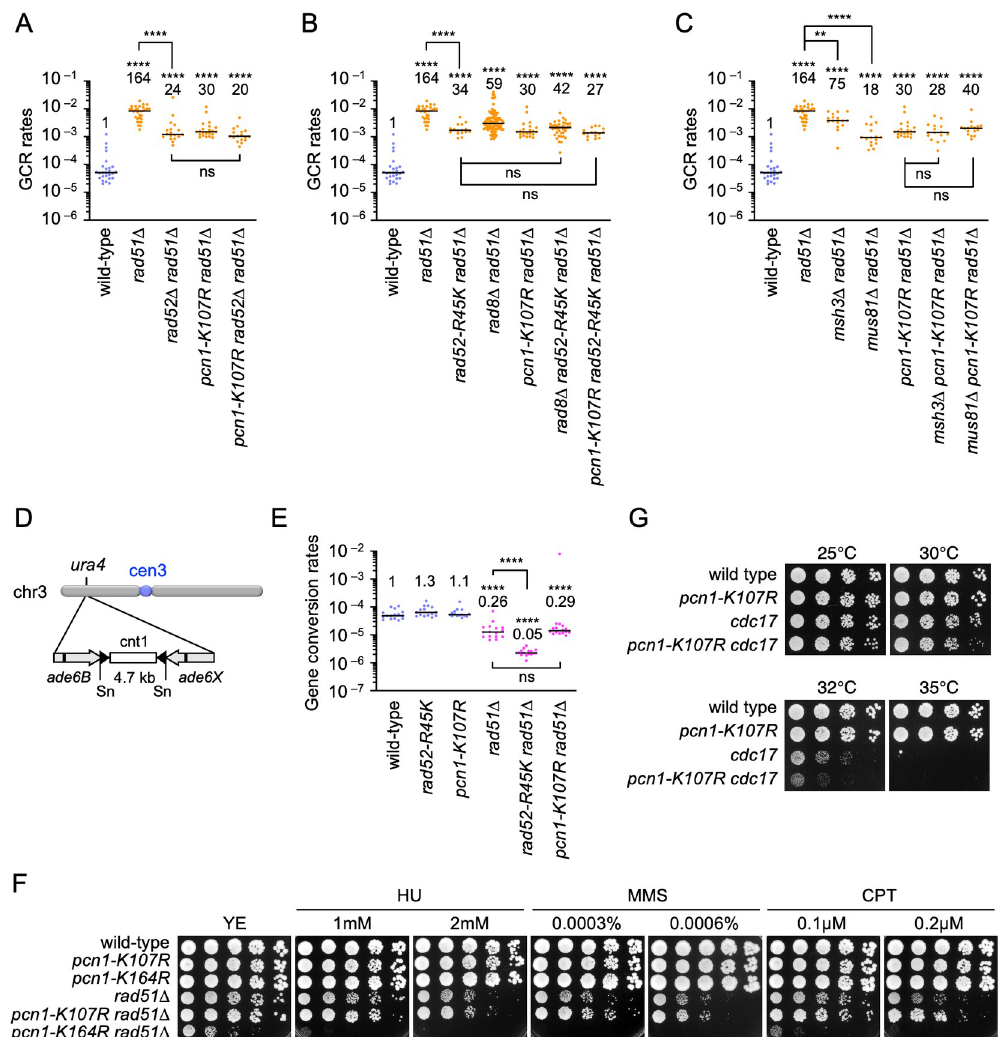
Fig 4. PCNA K107 is involved in the Rad52-dependent GCR pathway. (A) GCR rates of the wild-type, rad51 Δ , rad52 Δ rad51 Δ , pcn1-K107R rad51 Δ , and pcn1-K107R rad52 Δ rad51 Δ strains (TNF5369, 5411, 6692, 6761, and 6922, respectively). (B) GCR rates of the wild-type, rad51 Δ , rad52-R45K rad51 Δ , rad8 Δ rad51 Δ , pcn1-K107R rad51 Δ , rad8 Δ rad52-R45K rad51 Δ , and pcn1-K107R rad52-R45K rad51 Δ strains (TNF5369, 5411, 6616, 5644, 6761, 6704, and 7006, respectively). (C) GCR rates of the wild-type, rad51 Δ , msh3 Δ rad51 Δ , mus81 Δ rad51 Δ , pcn1-K107R rad51 Δ , msh3 Δ pcn1-K107R rad51 Δ , and mus81 Δ pcn1-K107R rad51 Δ strains (TNF5369, 5411, 7081, 5974, 6761, 6990, and 7203, respectively). (D) A schematic diagram illustrates the ade6B and ade6X inverted repeats integrated at the ura4 locus on the arm region of chr3. Sn, SnaBI. (E) Rates of gene conversion between ade6B and ade6X heteroalleles in the wild-type, rad52-R45K , pcn1-K107R , rad51 Δ , rad52-R45K rad51 Δ , and pcn1-K107R rad51 Δ strains (TNF3631, 5995, 7837, 3635, 6021, and 7918 respectively). The two-tailed Mann- Whitney test. Non-significant (ns) P > 0.05; �� P < 0.01; ���� P < 0.0001. (F) DNA damage sensitivity. Exponentially growing cells of the wild-type, pcn1-K107R , pcn1-K164R , rad51 Δ , pcn1-K107R rad51 Δ , and pcn1-K164R rad51 Δ strains (TNF35, 6968, 6948, 2610, 6988, and 6986, respectively) in YE media were five-fold serially diluted with sterilized water and spotted onto YE plates supplemented with HU, MMS, or CPT, at the indicated concentrations. (G) A serial dilution assay to examine temperature sensitive growth. Log-phase cultures of the wild-type, pcn1-K107R , cdc17-K42 , and pcn1-K107R cdc17-K42 strains (TNF35, 6968, 604, and 6973, respectively) prepared at 25˚C in YE media were five-fold serially diluted and spotted onto YE plates. The plates were incubated at the indicated temperatures for 3 to 4 days. Numerical source data underlying the graphs shown in (A-C) and (E) are provided respectively in Tables F, G, H, and I in S1 File.